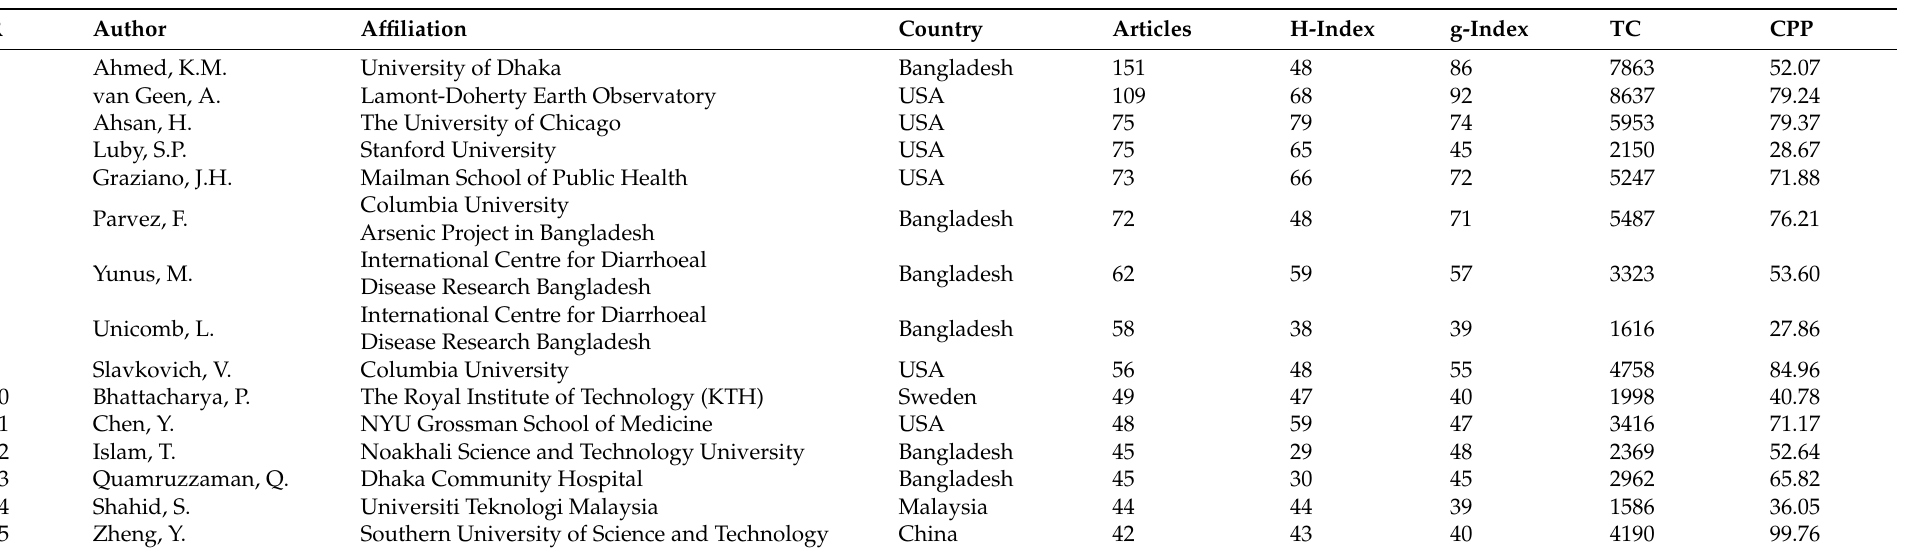
Table 7. Top 15 productive authors concerning Bangladesh water-research-related publications (Note: R is ranking of authors based on number of articles. TC is total citations. CPP is citations per